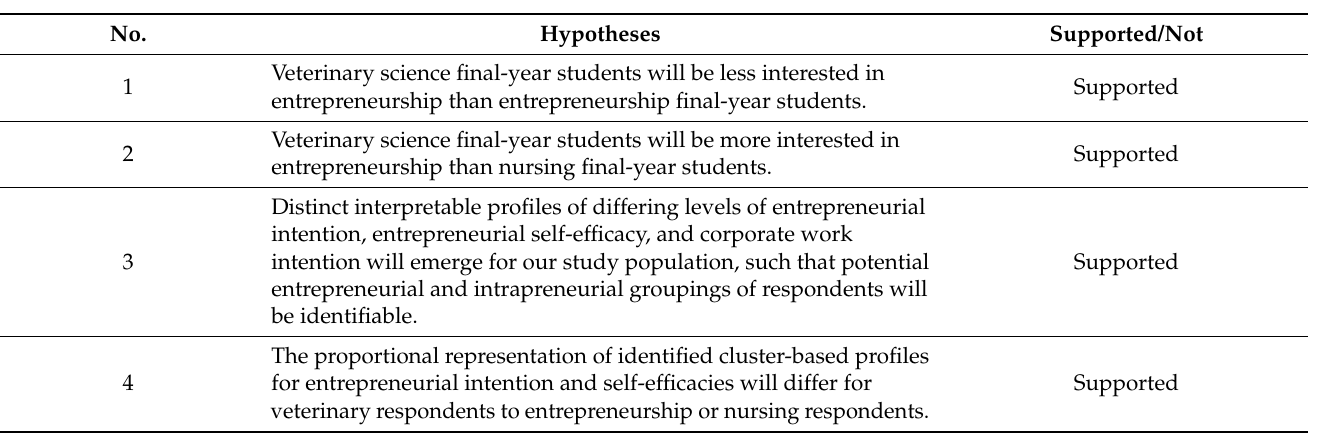
Table 7. Level of support for